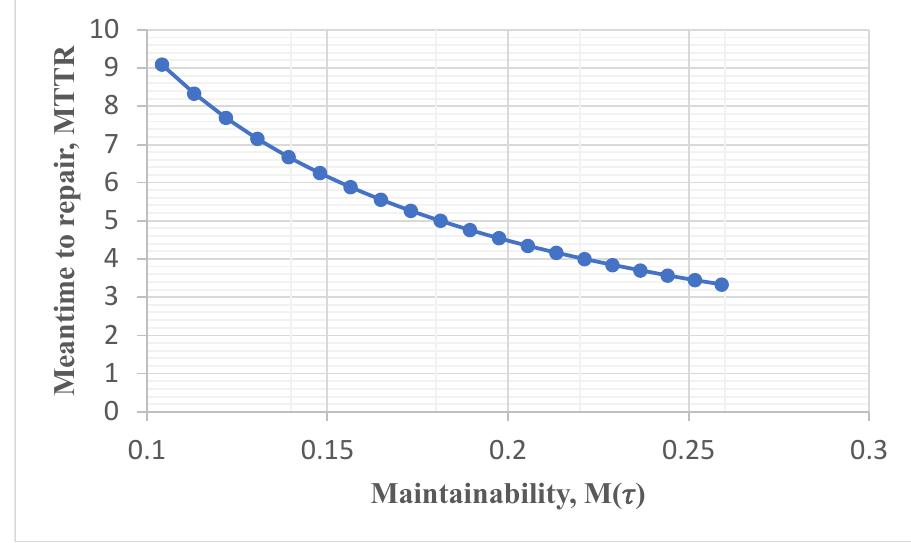
Figure 6. The relationship between average repair time MTTR and maintainability 𝑀(𝜏) .